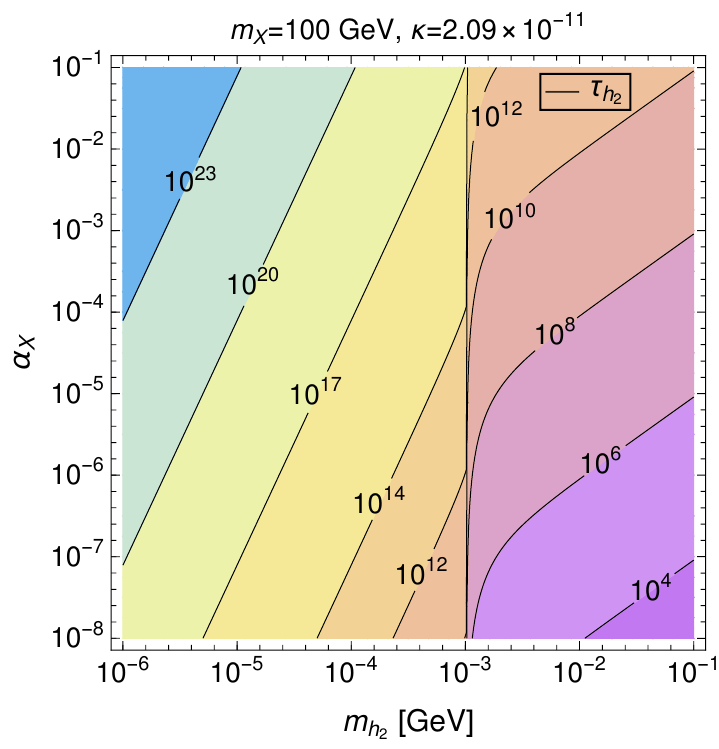
Figure 6 . Contour plot for the h 2 lifetime in the m h - (cid:11) X plane for VDM with m X = 100 GeV. 2 The Higgs portal coupling (cid:20) = 2 : 09 10 (cid:0) 11 is determined by the VDM relic density through the (cid:2) freeze-in mechanism. The numbers on the line represent the h 2 lifetime in units of